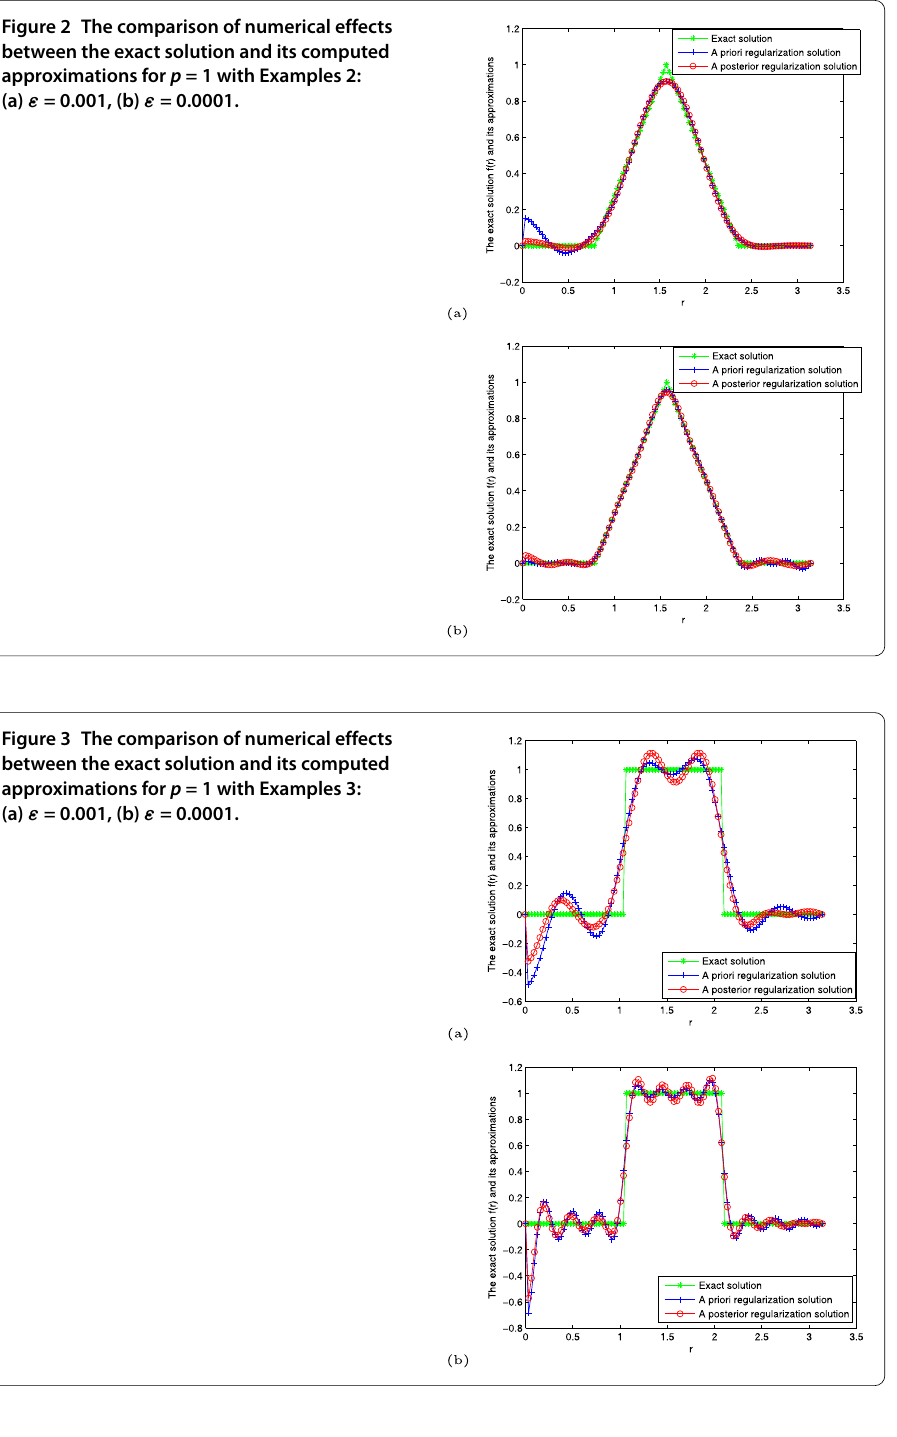
Figure 2 The comparison of numerical effects between the exact solution and its computed approximations for p = 1 with Examples 2: (a) ε = 0.001, (b) ε = 0.0001.